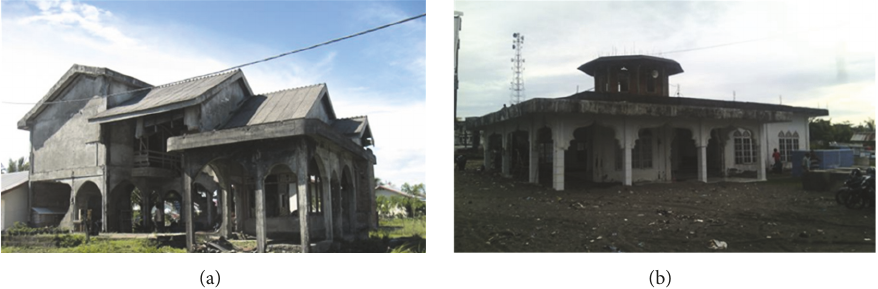
Figure 5: Buildings submerged by the tsunami: (a) Objects I and (b) Object II.